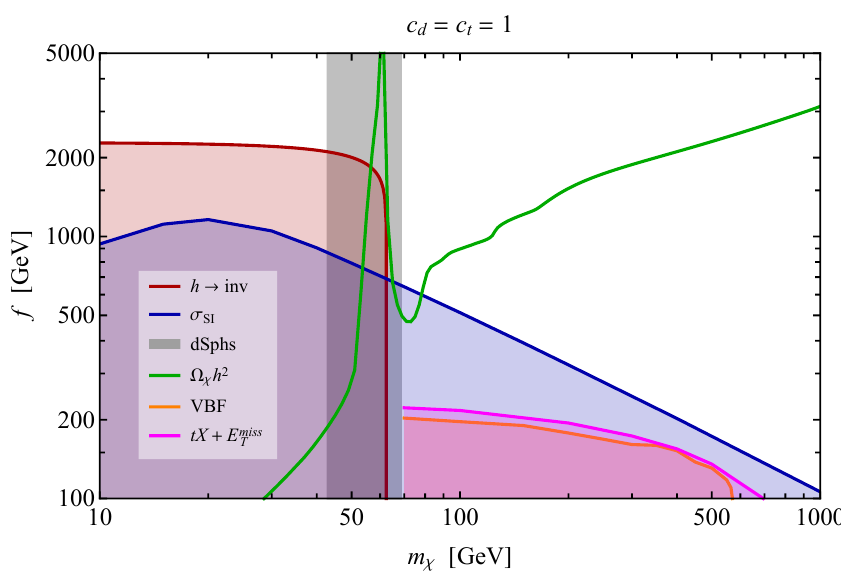
Figure 7 . As figure 6 but for the pNGB DM benchmark model with c d = c t = 1 . The blue region is excluded by the 90% CL bound on the SI DM-nucleon cross section σ SI as determined by XENON1T [107].